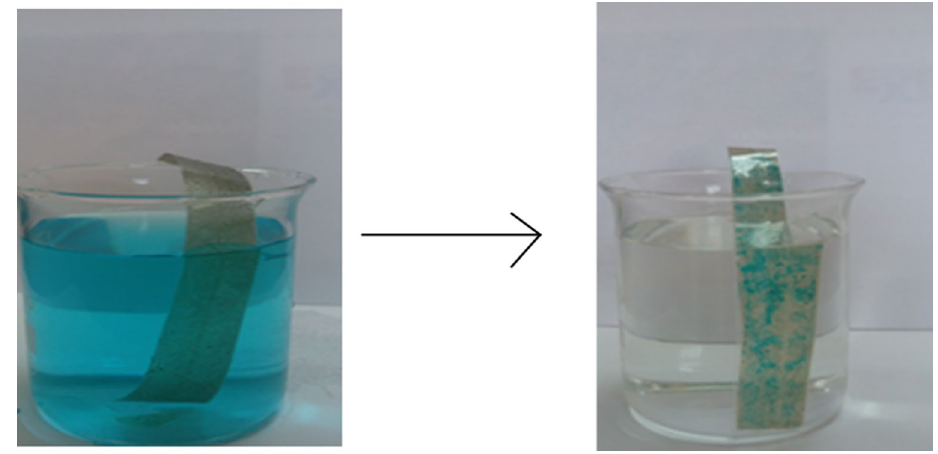
Fig. 3 Removal of MB from water in the